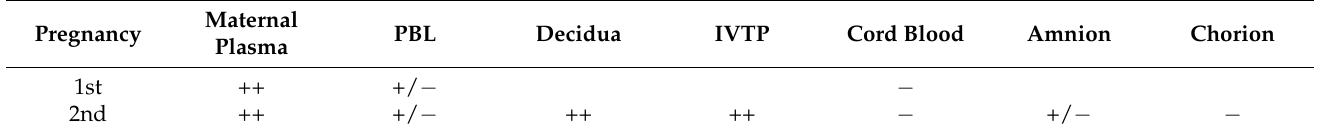
Table 1. Detection of Pegivirus (HPgV) nucleic acid by end-point PCR in maternal 1 st -trimester plasma, peripheral blood leukocytes (PBL), decidual and intervillous tissue of the placenta (IVTP), and fetal (cord blood, amnion, and chorion)